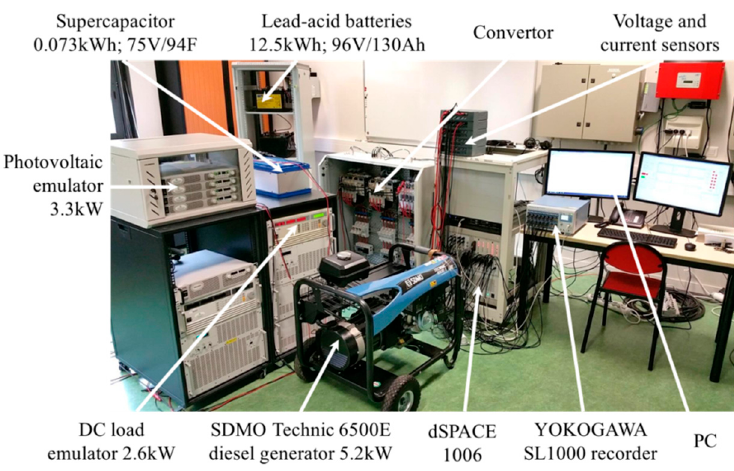
Figure 4. Autonomous DC microgrid experimental platform.